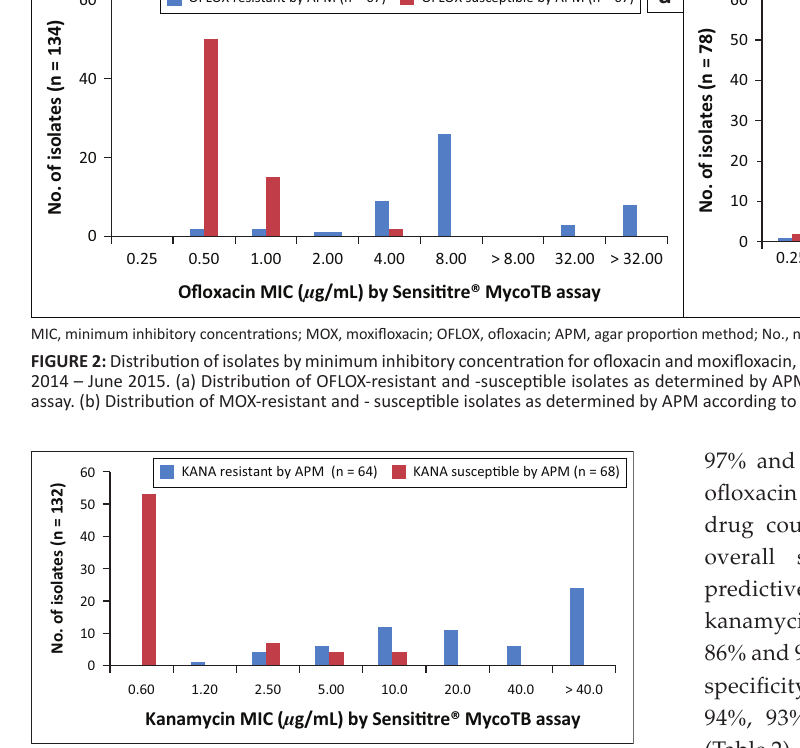
FIGURE 3: Distribution of isolates by minimum inhibitory concentration for kanamycin, Inkosi Albert Luthuli Central Hospital, Durban, South Africa, January 2014 – June 2015. Distribution of KANA-resistant and -susceptible isolates as determined by APM according to their MIC as determined by the Sensititre® MycoTB